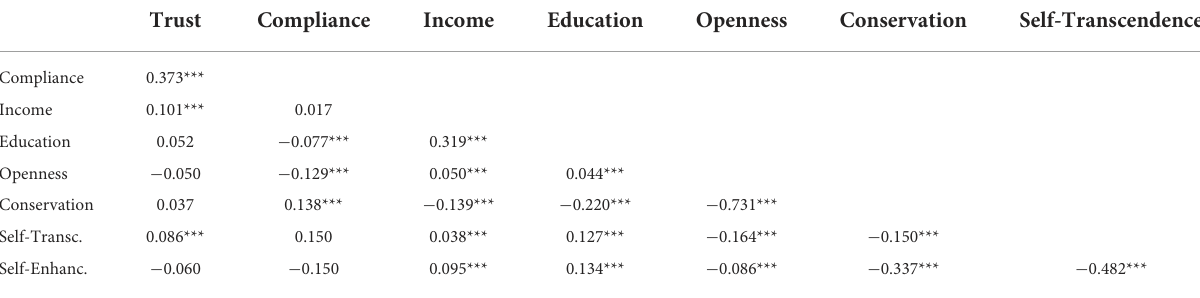
TABLE 2 Bivariate correlations between the milieu components and the social cohesion factors. Trust Income